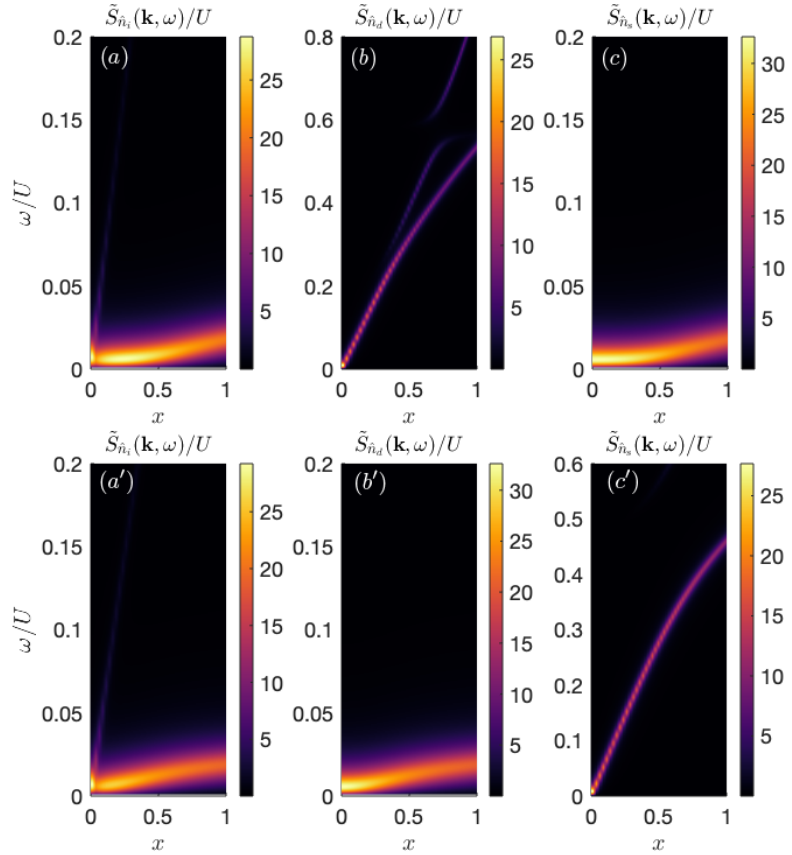
( k , ω ) = S ( k , ω ) / S ( k ) for (a)- ˆ F ˆ F F = ˆ n , (b)-(b ′ ) the total density channel r 1, r = ˆ n − ˆ n in the SF phase in the r 1, r 2, r = 1, see d / U = − 0.7, µ/ U ≈ − 0.35, 12